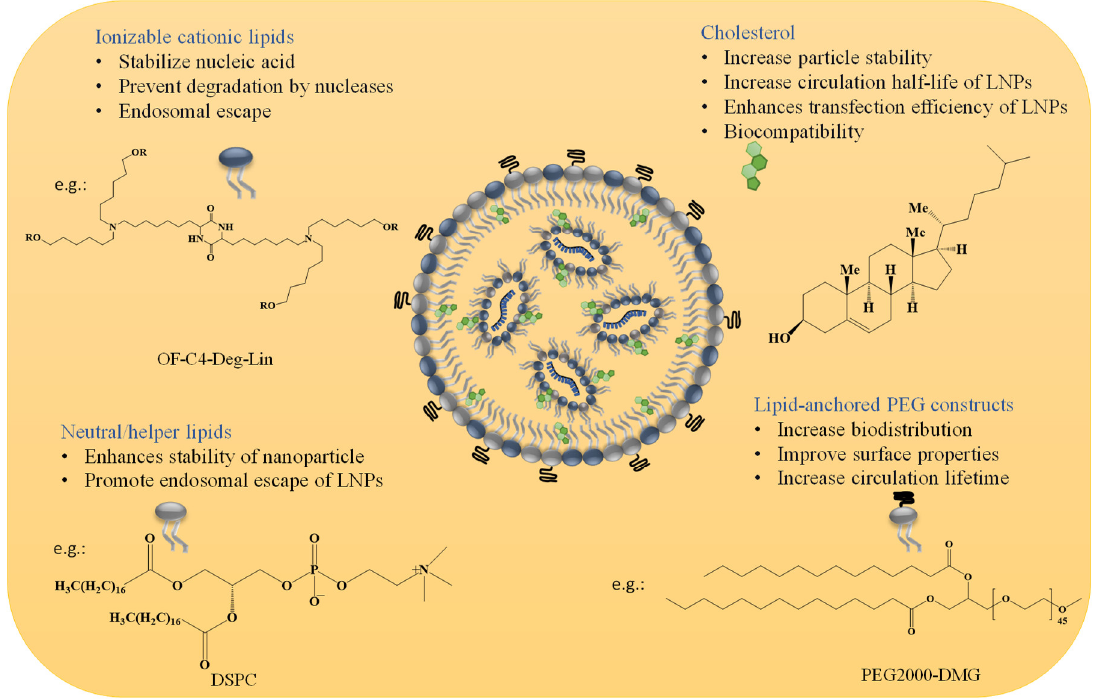
Figure 1. Composition of LNPs and importance of each component.